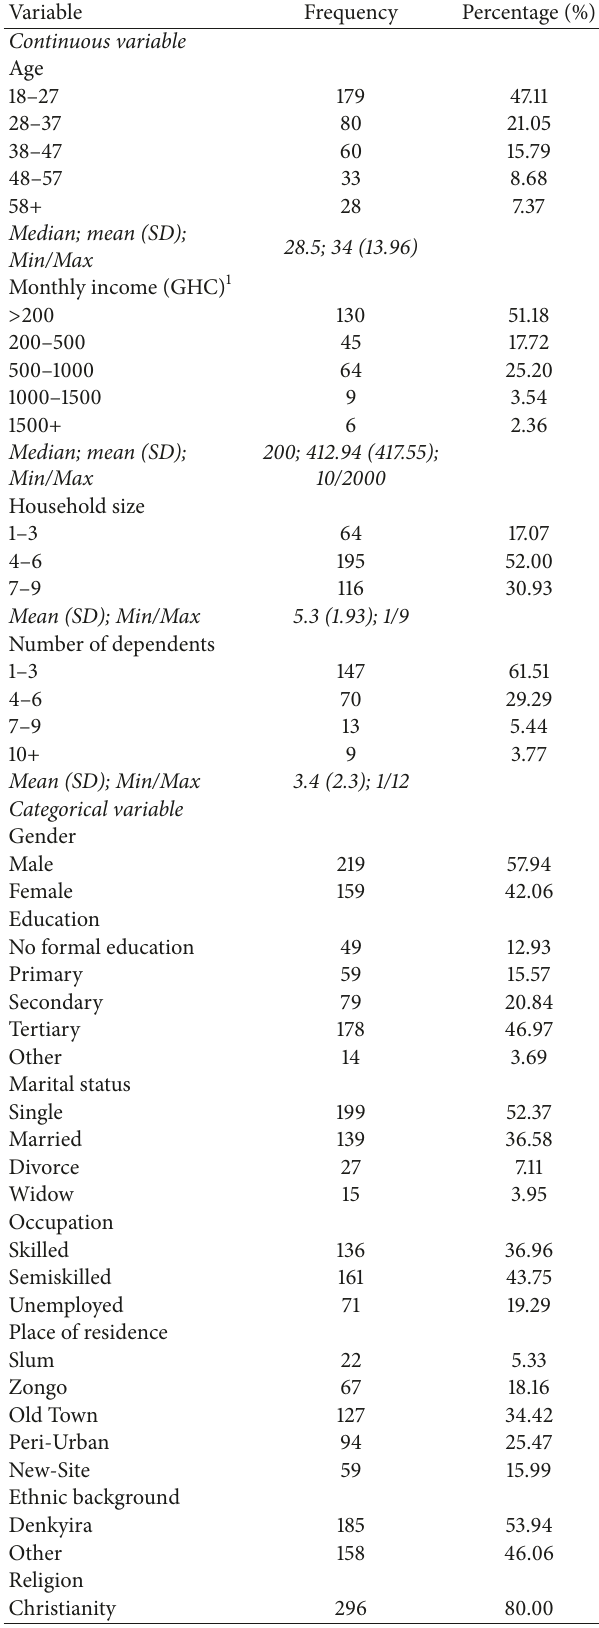
Table 1: Sociodemographic characteristics of